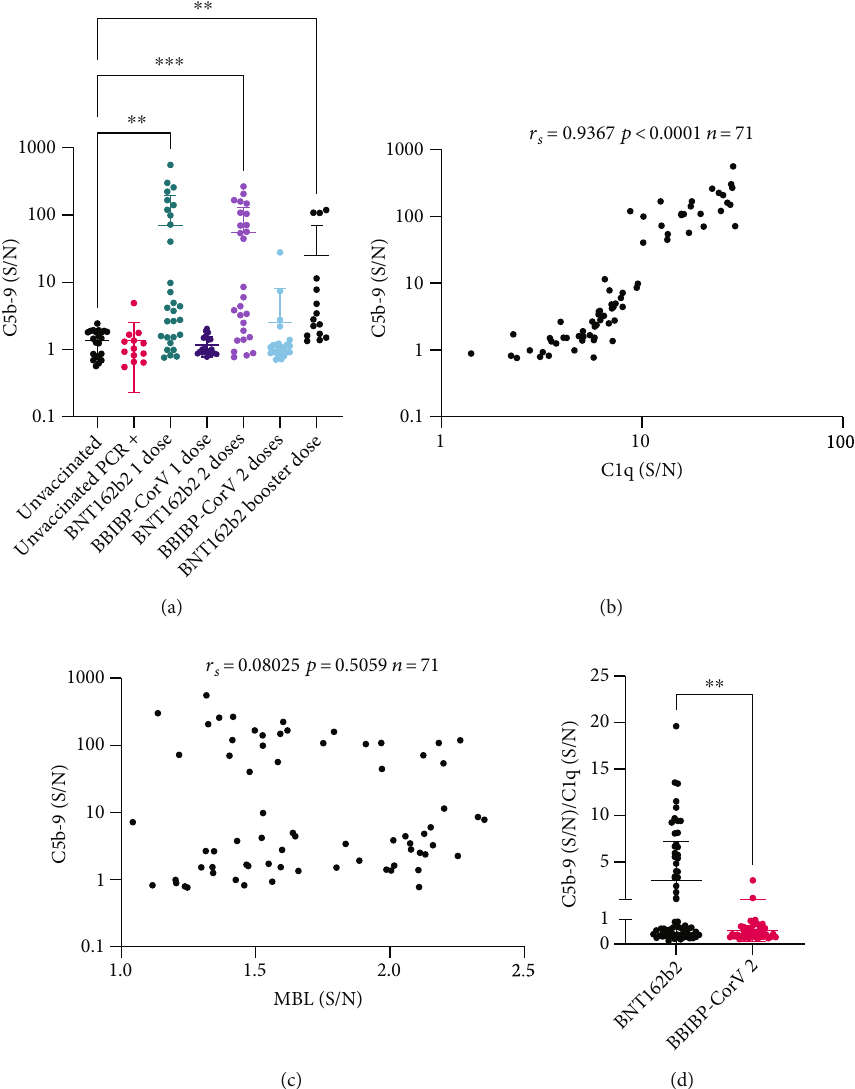
Figure 3: Measurement of C5b-9 formation. Participants were divided by their vaccination status, type of vaccine, and dose of vaccine. Serum samples were incubated with RBD-coated plates; the formation of C5b-9 was subsequently measured using an indirect immunoassay. (S/N) represents the chemiluminescence signal generated from wells incubated with 1% serum divided by the signal in control wells incubated with PBST. (a) Represents formed C5b-9 levels while (b) and (c) represents a scatter plot that correlates C5b-9 to C1q and MBL levels, respectively, in BNT162b2 vaccinated individuals, Spearman ’ s correlation coe ffi cient (r of participants ( n ) are displayed on the plot. (d) Individual values of C5b-9 per C1q in each participant were calculated and displayed in a scatter plot for the two types of vaccines. In scatter plots, each circle represents one participant, bold horizontal lines represent the mean of each group, while whiskers represent the standard deviation. Some error bars were clipped at the axis limit. Dunn ’ s multiple comparisons statistical test following Kruskal – Wallis test was used to compare various groups to the unvaccinated group. Only signi fi cant pairwise comparisons are displayed, ∗∗ P ≤ 0 : 01 , ∗∗∗ P ≤ 0 : 001